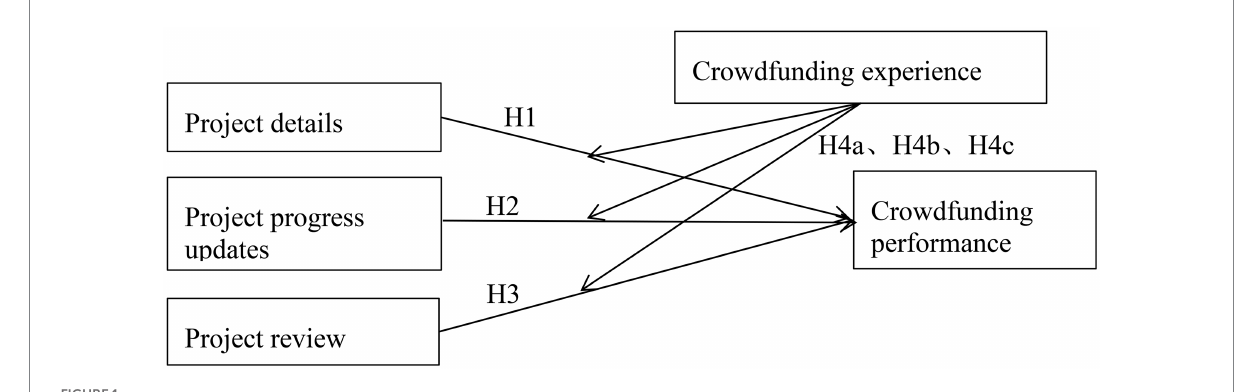
FIGURE 1 Conceptual model of the study.